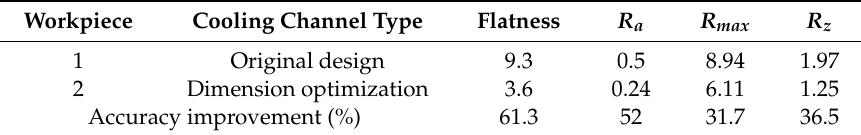
Table 9. Machining accuracy results in the machining